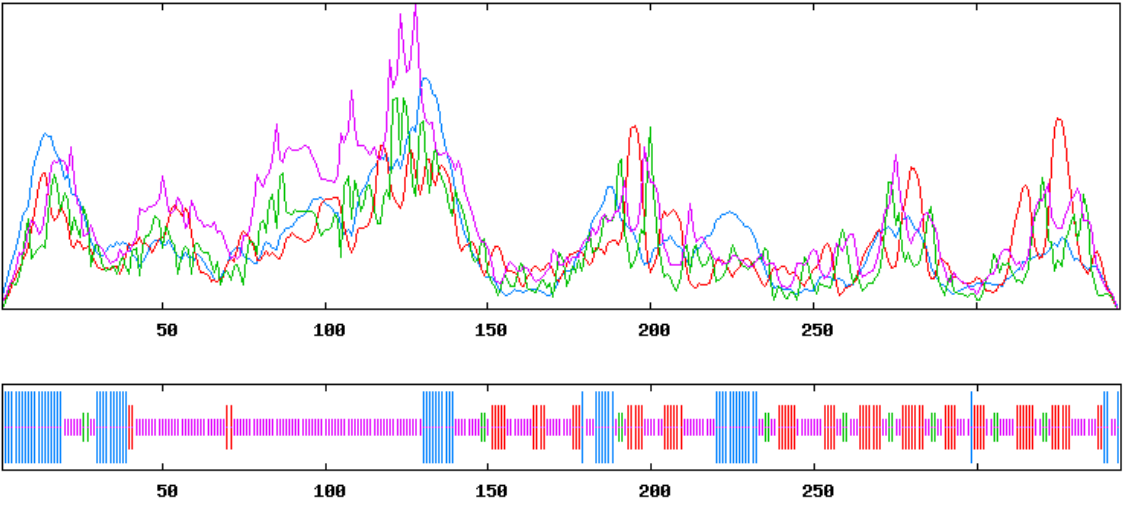
Figure 1. Secondary structure of the expansin protein obtained by using SOMPA. Here, helix, random coil, extended strand and beta-turn are blue, magenta, red and green, respectively. Also shown as a bar diagram.